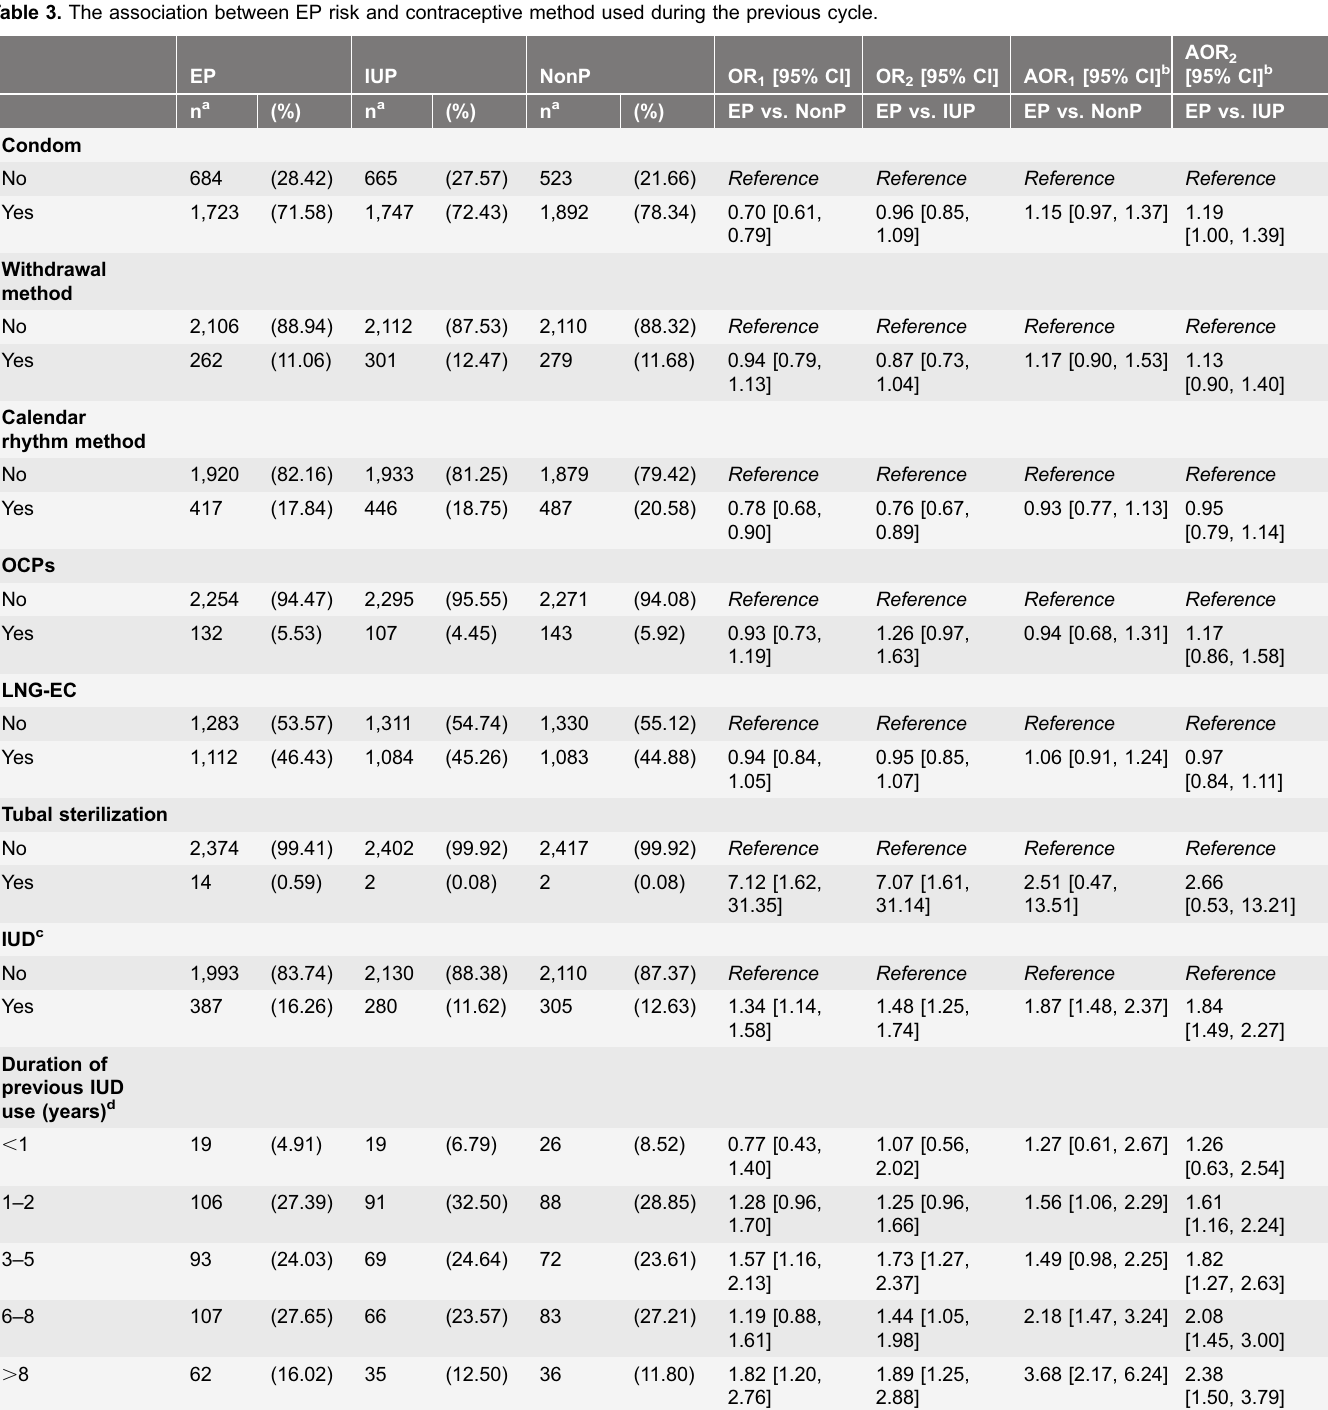
Table 3. The association between EP risk and contraceptive method used during the previous cycle.